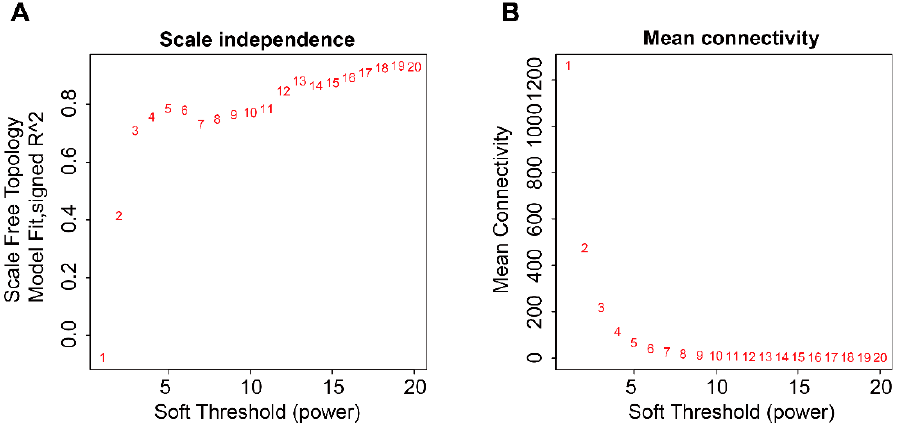
12 of 25 Figure 12. Association of TME-related subtypes with immunotherapy. ( A ) Comparisons of nor- malized TIDE scores between subtypes 1 and 2. ( B ) Comparison of IPS between subtypes 1 and 2. 3.9. Identification of a Module Highly Correlated with TME-Related Subtypes First, no abnormal samples and genes were found using the “goodSamplesGenes” function. The hierarchical clustering tree was drawn for 79 samples and no obvious out- lier samples were found (Figure S5). As such, 5000 high MAD genes and 79 ACC subjects were retained for subsequent WGCNA analysis. The best soft threshold ( β = 13) was ob-